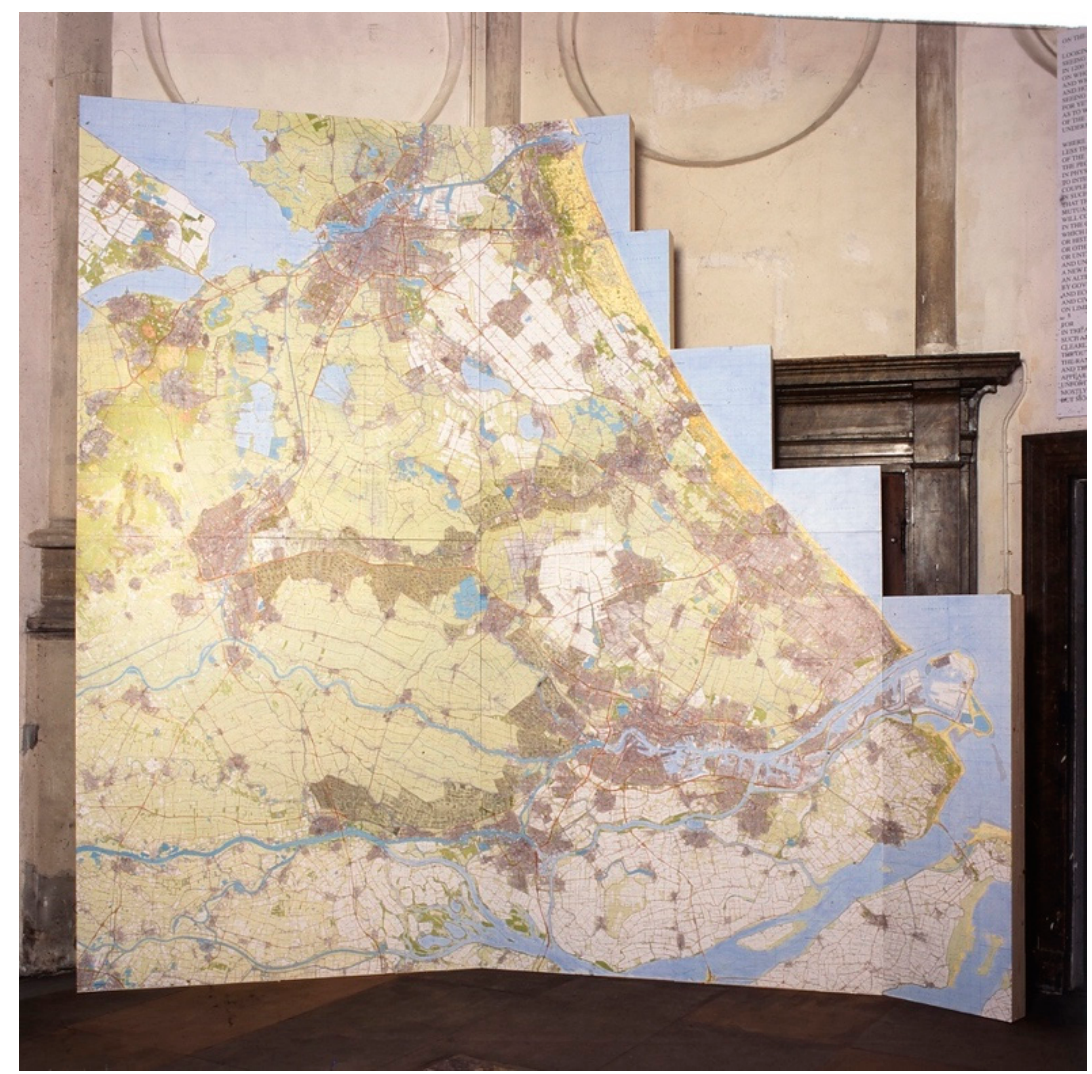
Figure 5. Map of the Netherlands printed backwards and broken into three parts (Harrison and Harrison p. 259) (Courtesy of the artist Newton Harrison).